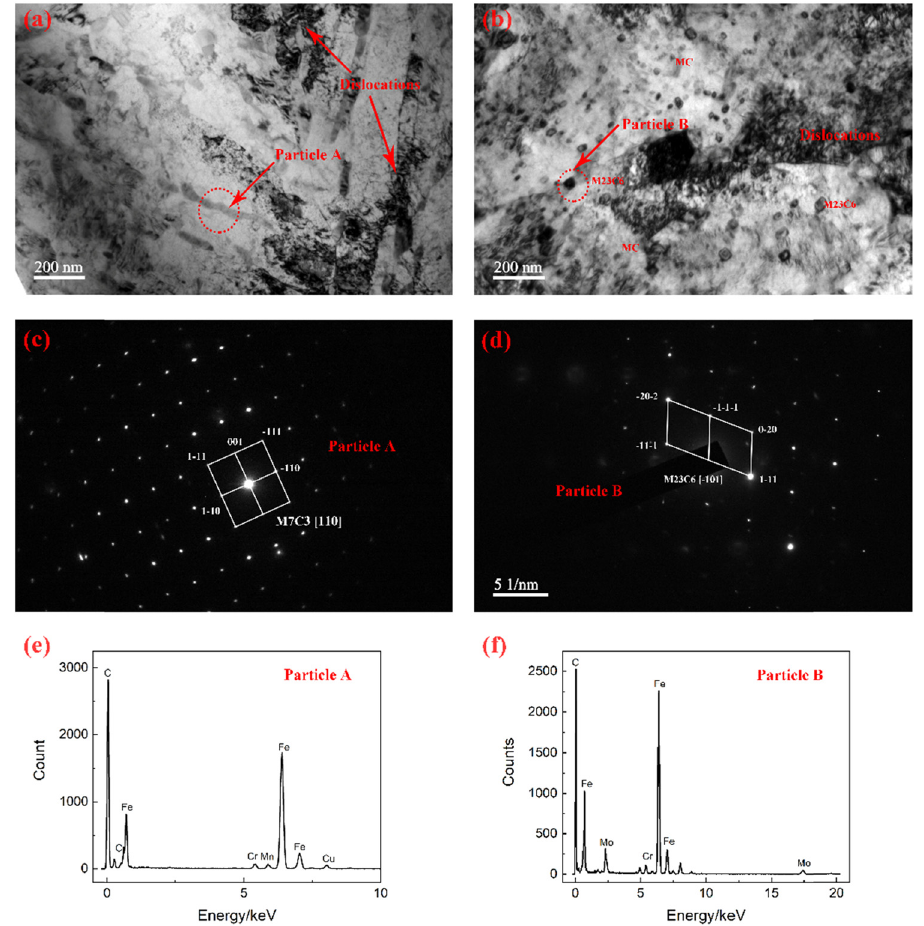
Figure 7: The initial microstructure of the two steels by TEM: ( a ) 5CrNiMoV, ( b ) 5CrNiMoVNb, ( c ) di ff raction of particle A, ( d ) di ff raction of particle B, ( e ) energy spectra of particle A, and ( f ) energy spectra of particle